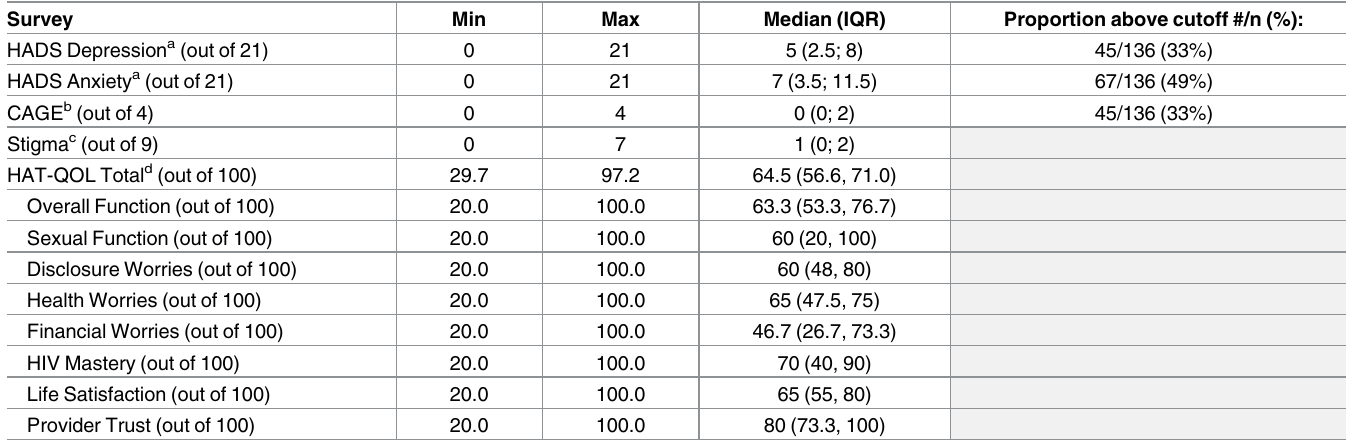
Table 2. Mental health indicators at ART initiation (n = 136).